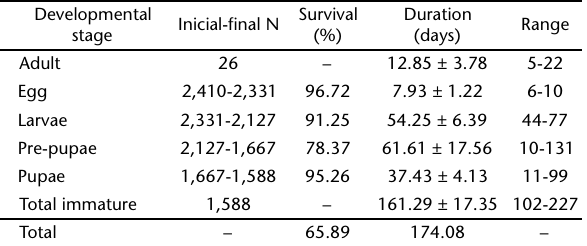
Table I. Survival and duration of the life cycle of Agrotis malefida during different stages of development, under controlled